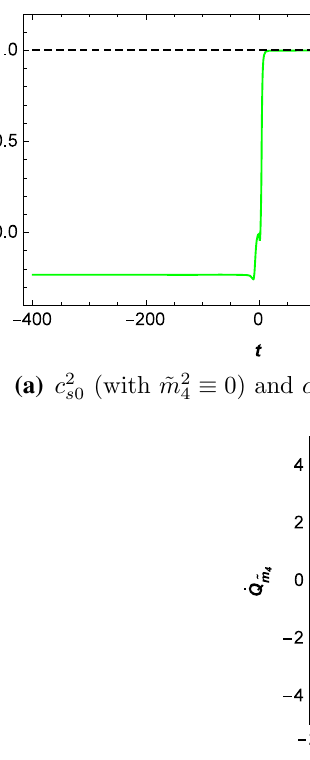
, while we set f 1 = 5, f 2 = − 0 . 23, f 3 = − 13 f 2 , q 1 = 1, q 2 = 0 . 2, 4